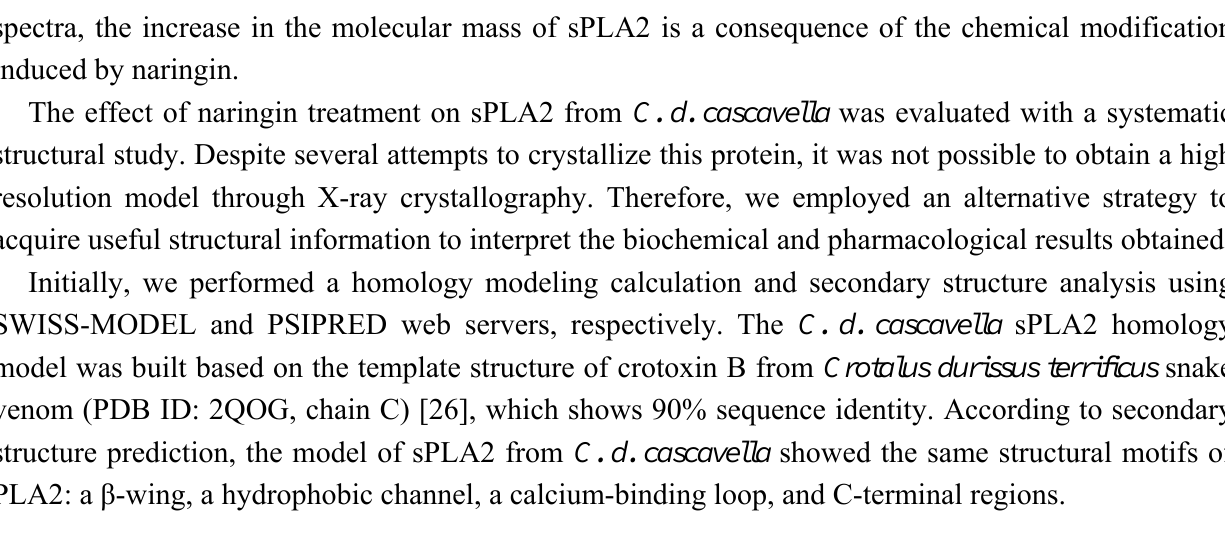
Figure 4. (a) Effect of naringin on the sPLA2 antibacterial activity against Staphylococcus mutans . b) Observed structural modifications induced by sPLA2 and sPLA2-Nar on Xanthomonas axonopodis pv passiflorae . Saline was used as a control. CFU: Colony Forming